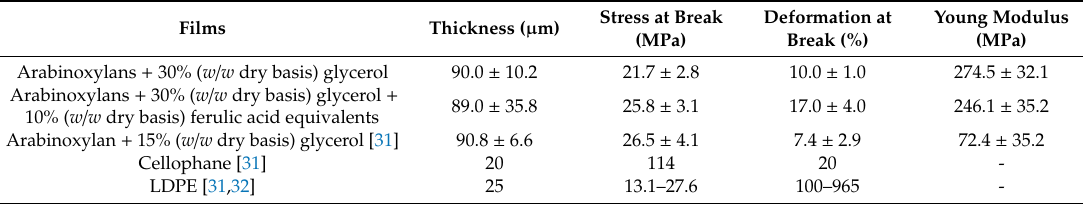
Table 7. Mechanical properties under tensile tests of arabinoxylan-based films and commercial Cellophane and